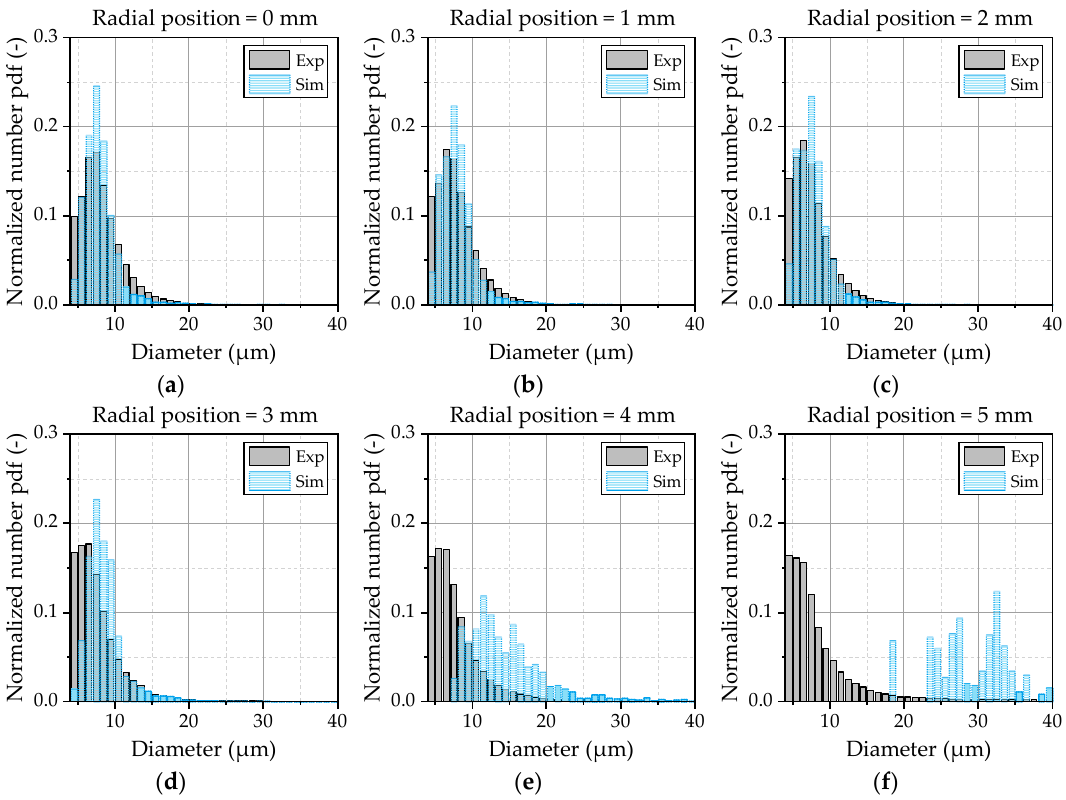
Figure 15. Normalized number-based droplet distribution for OP 2 at the first measurement position in a radial distance of 0 mm ( a ); 1 mm ( b ); 2 mm ( c ); 3 mm ( d ); 4 mm ( e ) and 5 mm ( f ).